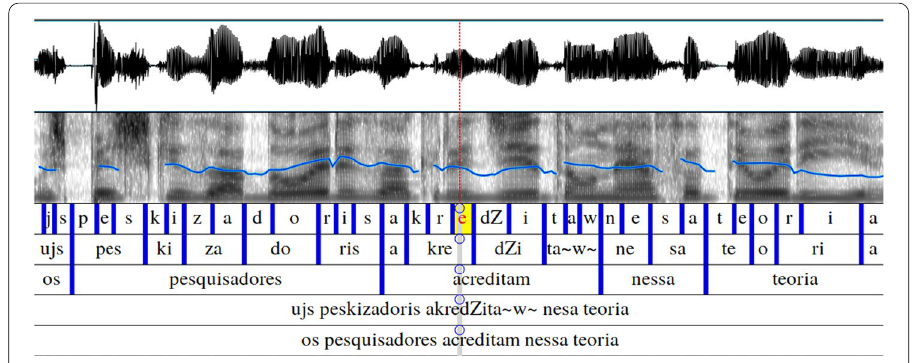
Fig. 1 Visualization of a TextGrid file via Praat’s editor, including five tiers: phonemes, syllables, words, and phonetic and orthographic transcription, respectively. FalaBrasil’s G2P [10, 11] and syllabification [12] library provide phonetic and syllabic tokens, respectively, from text. Praat [7] is responsible for plotting the audio’s waveform in both time and frequency domains, while Kaldi [6] provides the temporal marks for the dark-blue vertical bars that keep tokens apart from each